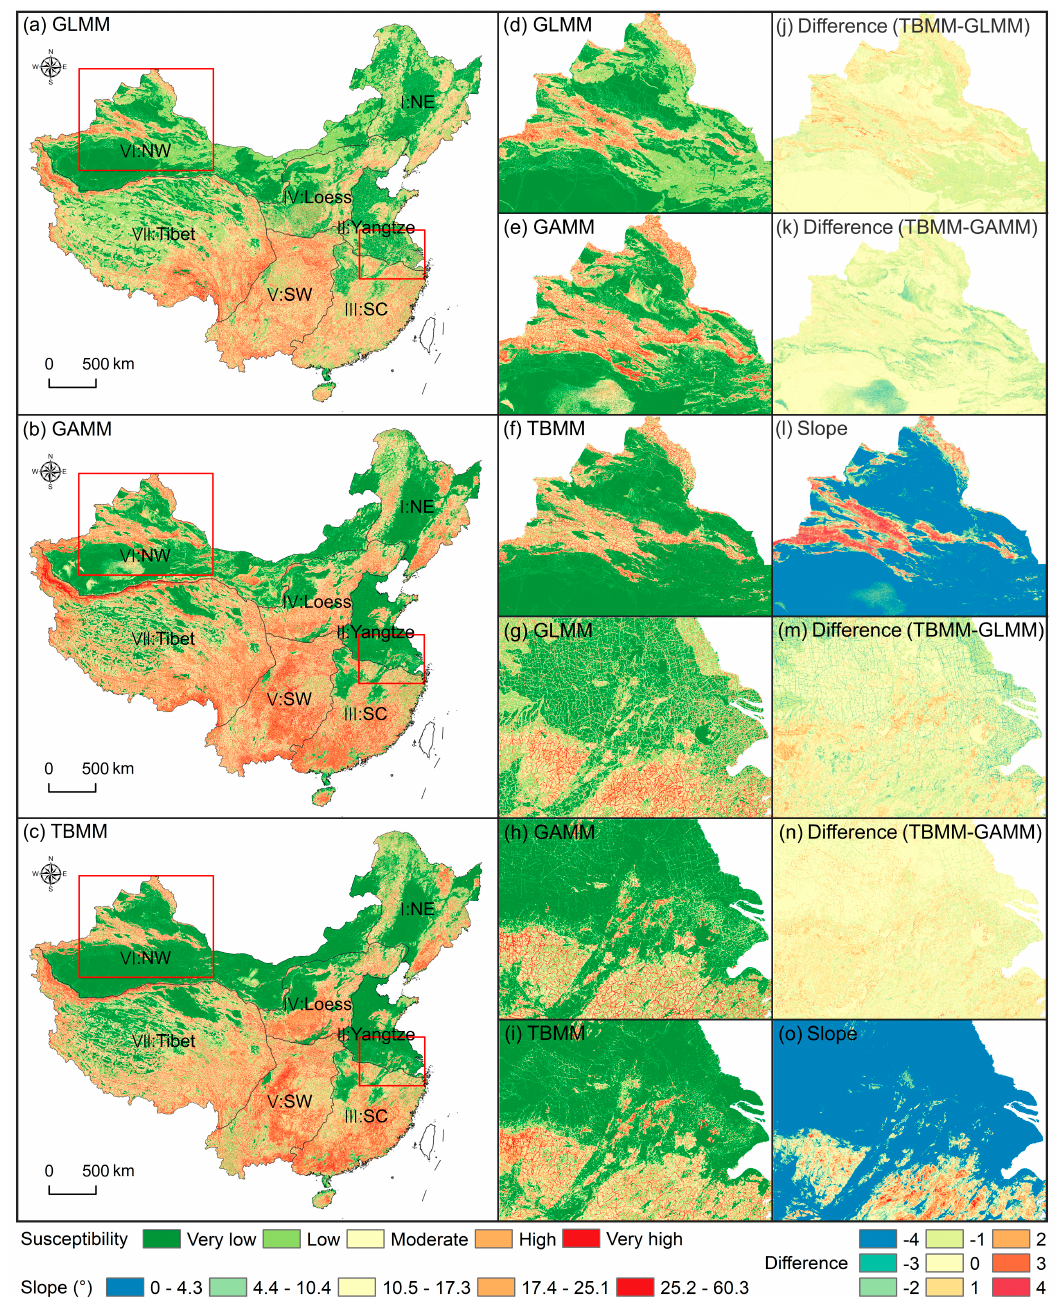
Figure 9. Rockfall susceptibility maps. ( a–i ) Susceptibility maps for China and local areas yielded by three mixed models; ( j,k,m,n ) the difference between TBMM and other models in local areas; ( l,o ) the topography slope in local areas.